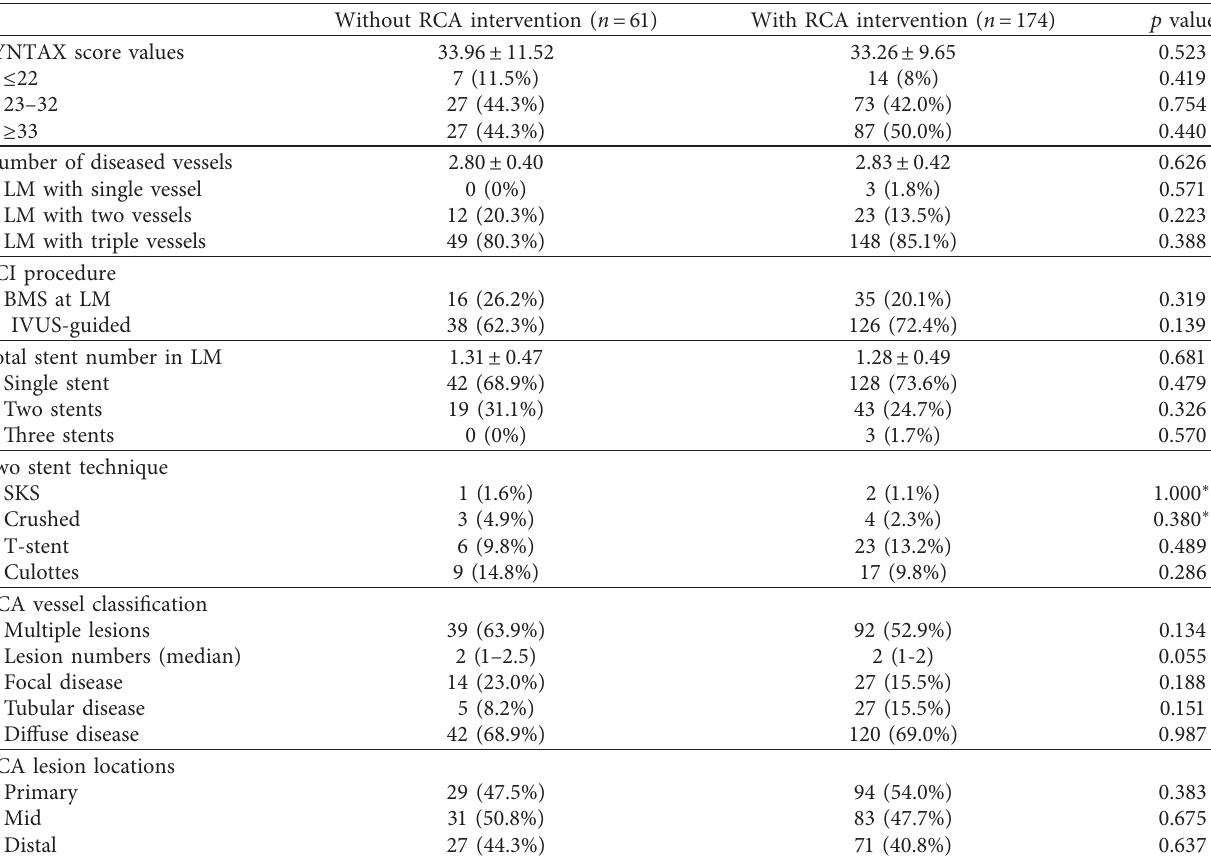
Table 2: Angiographic and procedure outcome between the two